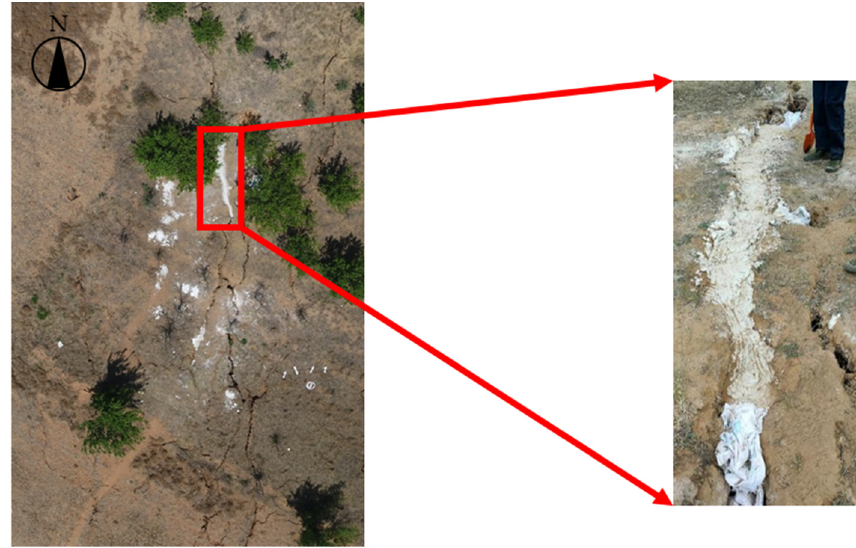
Figure 3. Field filling results of the ground fissure.